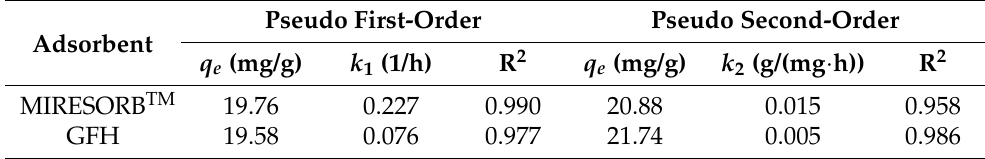
Table 3. Kinetic parameters for As(V) adsorption by MIRESORB TM and GFH materials.